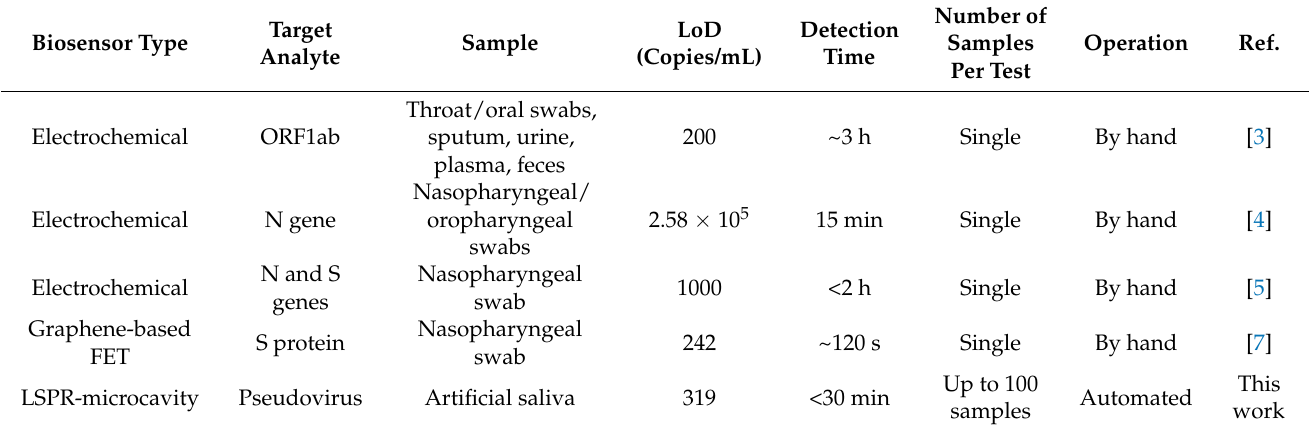
Table 3. Performance of the latest biosensors for SARS-CoV-2 detection reported in